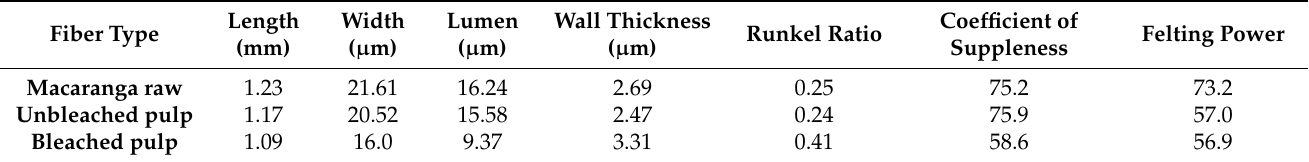
Table 2. Fiber morphology of Macaranga gigantea after pulping and bleaching.